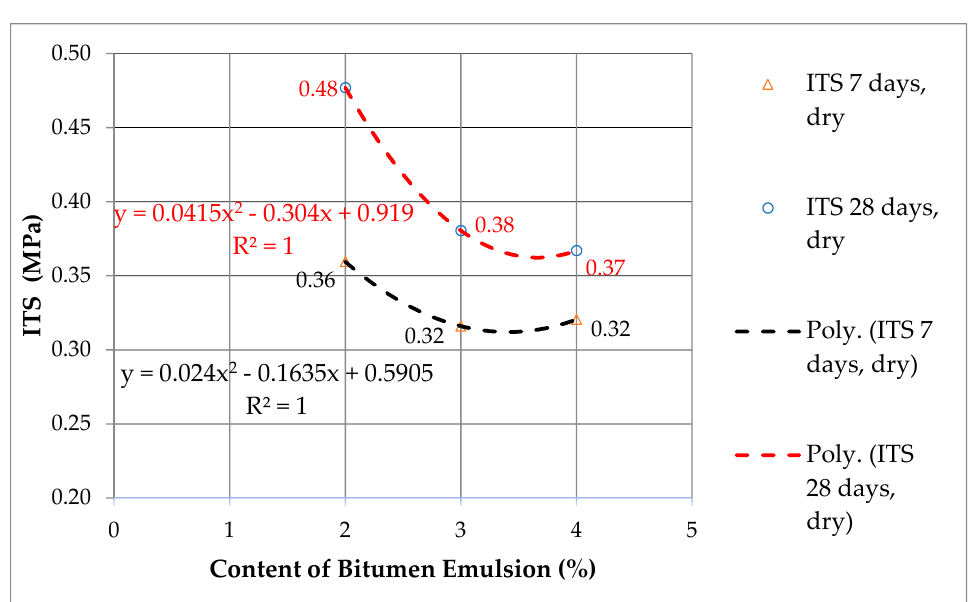
Figure 3. Dependence of indirect tensile strength (ITS) on emulsion content, dry specimens.